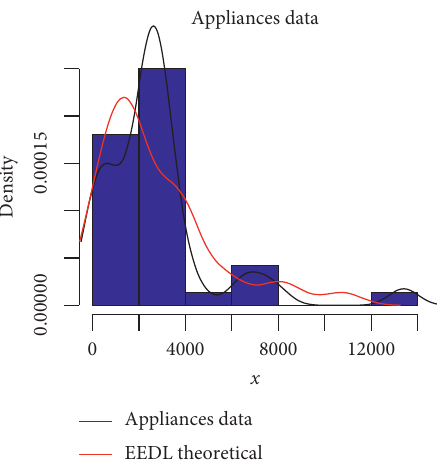
Figure 4: Failure time on appliances. Table 3: MLE of parameters and standard errors for appliances data.